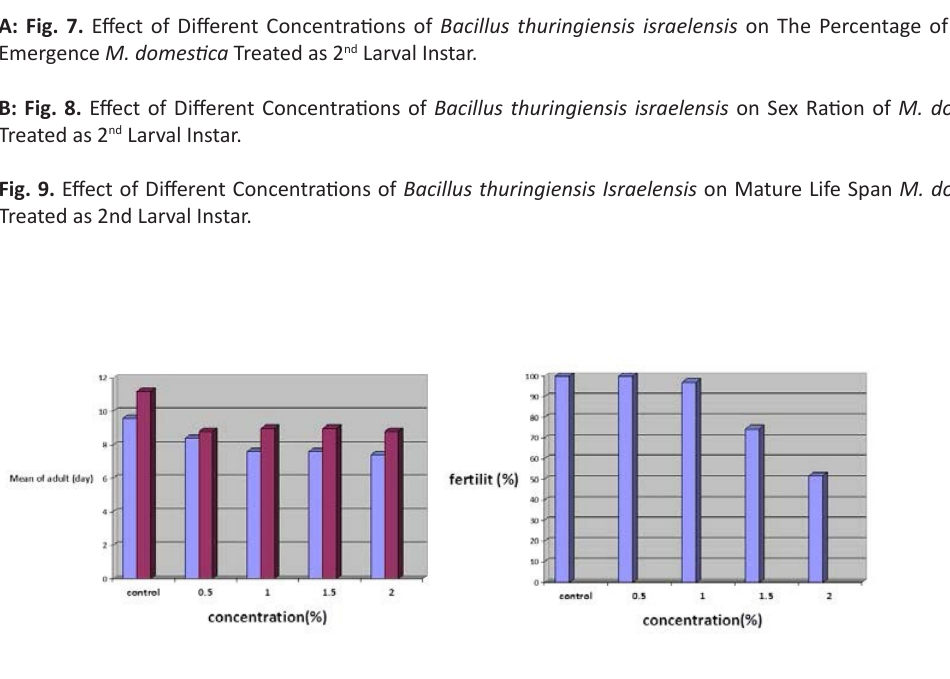
Fig. 10. Effect of Different Concentrations of Bacillus thuringiensis israelensis on Eggs Female (days) M. domestica treated as 2nd larval Instar.